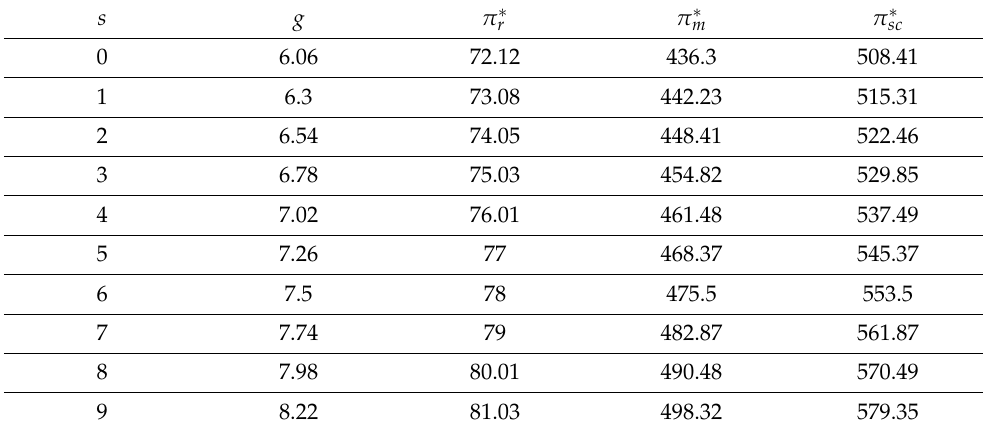
Table 3. Product green degree and supply chain profit under different government